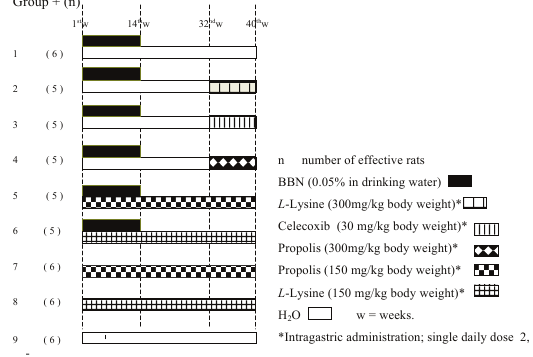
FIGURE 1 - Design of the